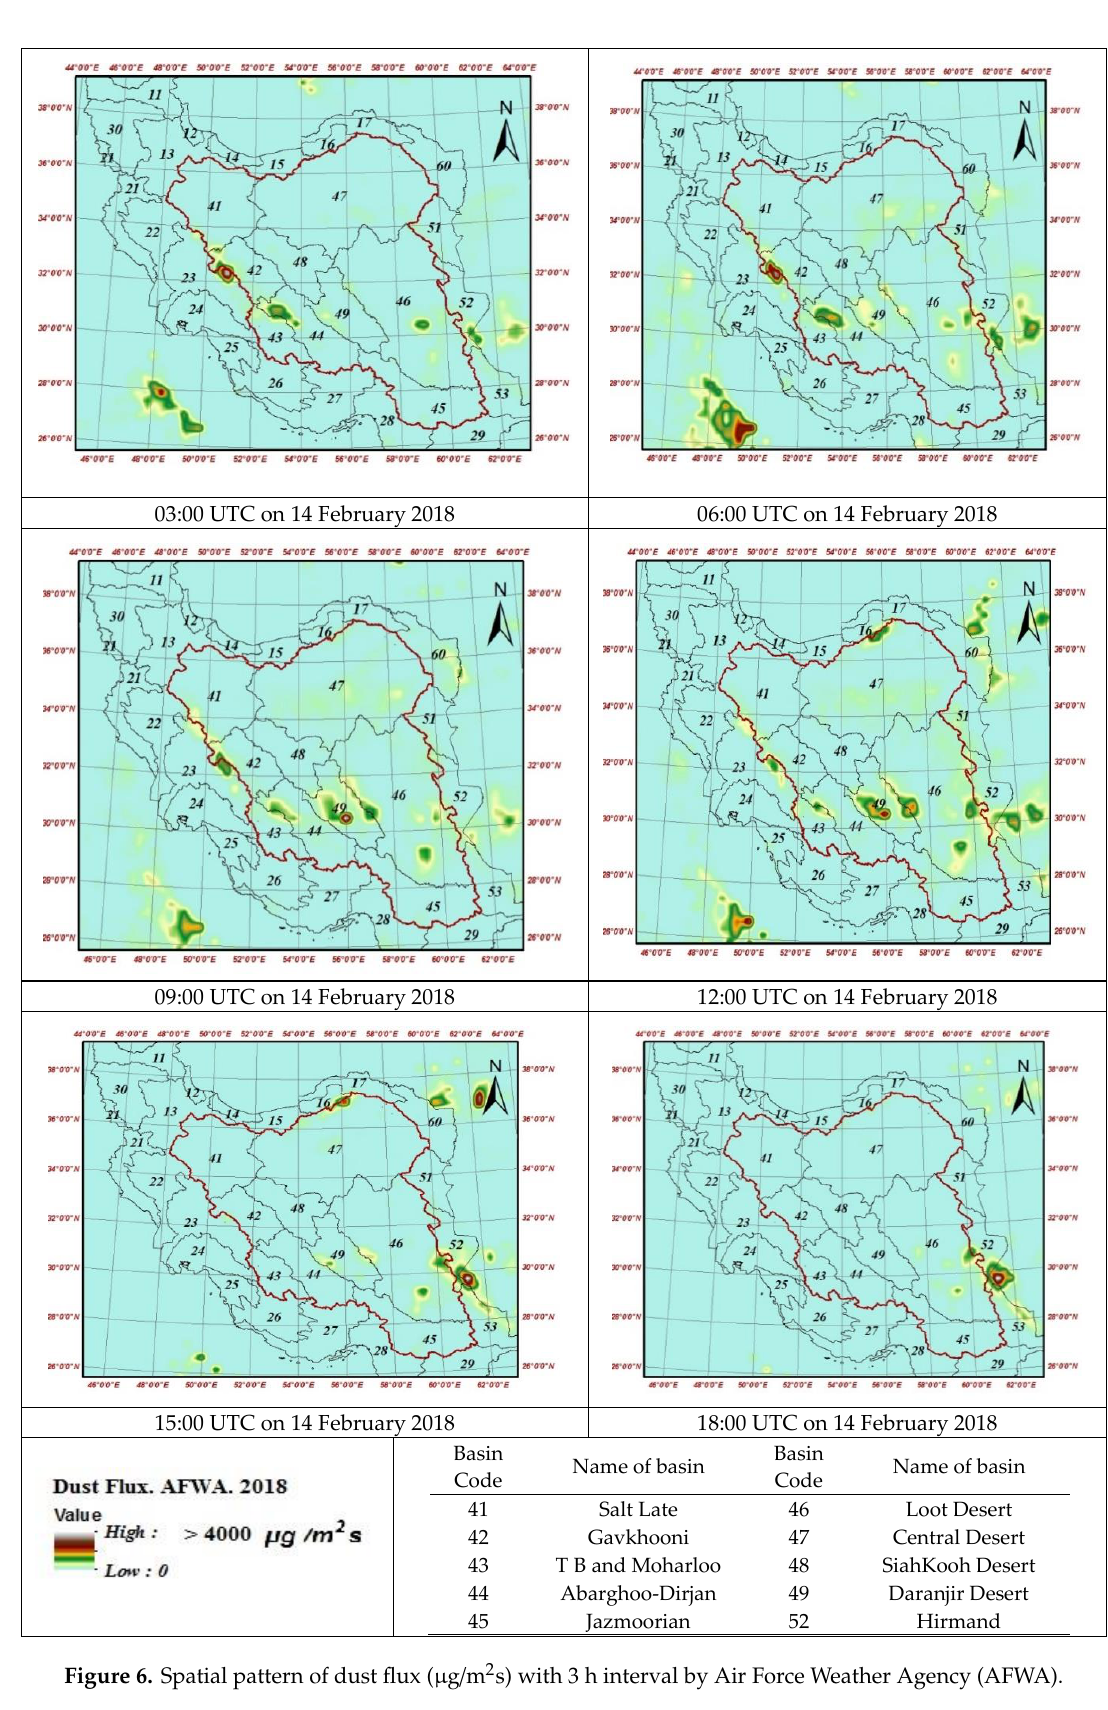
Figure 6. Spatial pattern of dust flux (µg/m 2 s) with 3 h interval by Air Force Weather Agency (AFWA).